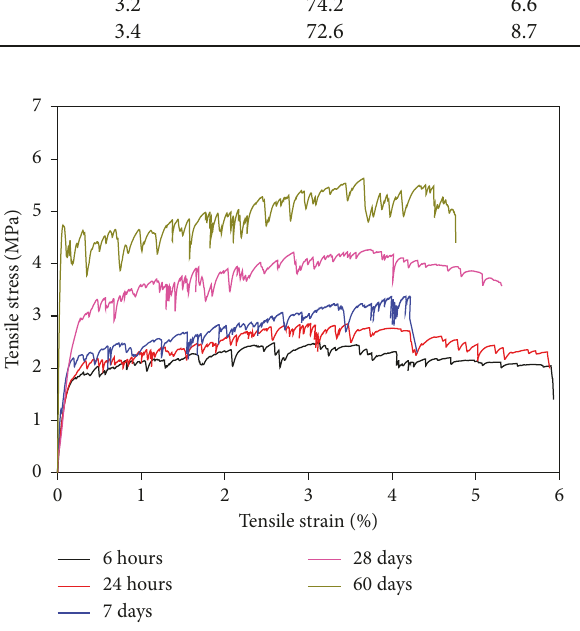
Figure 15: Tensile stress-strain curves of ECC4 with different curing ages.